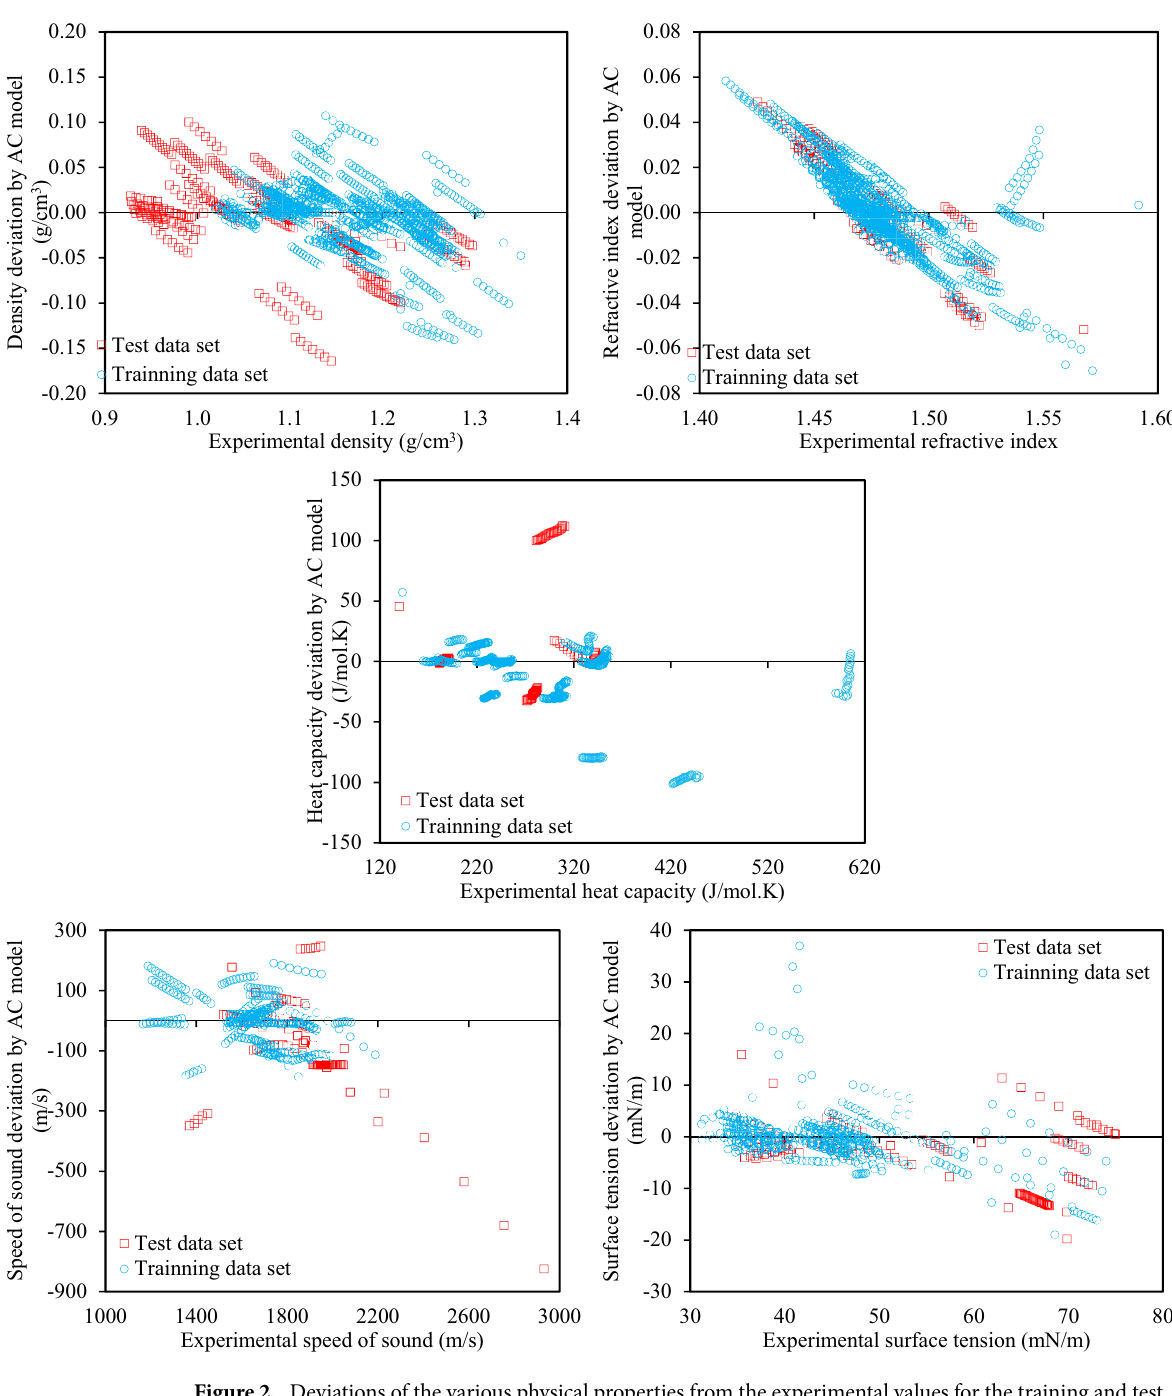
Figure 2. Deviations of the various physical properties from the experimental values for the training and test data sets by the proposed AC